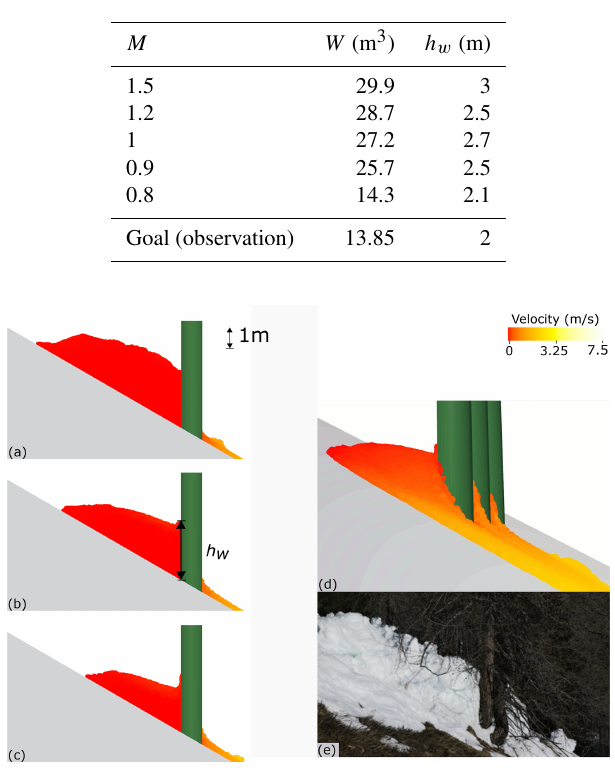
Figure 2. Cross-sectional view (passing through the centre of the middle tree) of the snow stopped behind a group of three trees for different values of M : (a) M = 1 . 2, (b) M = 1, and (c) M = 0 . 8. Perspective view of the stopped mass (d) in the simulation with M = 0 . 8 and d = 1m and (e) from the field observation (Feistl et al., 2014).